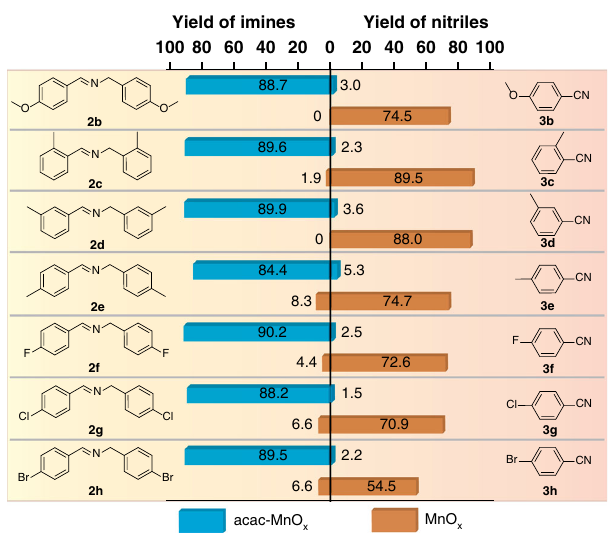
Fig. 4 Synthesis of nitriles and imines using benzylamine derivatives over unmodi fi ed and acac-modi fi ed MnO x . Reaction conditions: 1 mmol benzylamine, 0.1 mmol MnO x , acac/MnO x = 20 mol% for acac-MnO x , 5 mL CH 3 CN, 0.3 MPa O 2 , 90 °C, 14